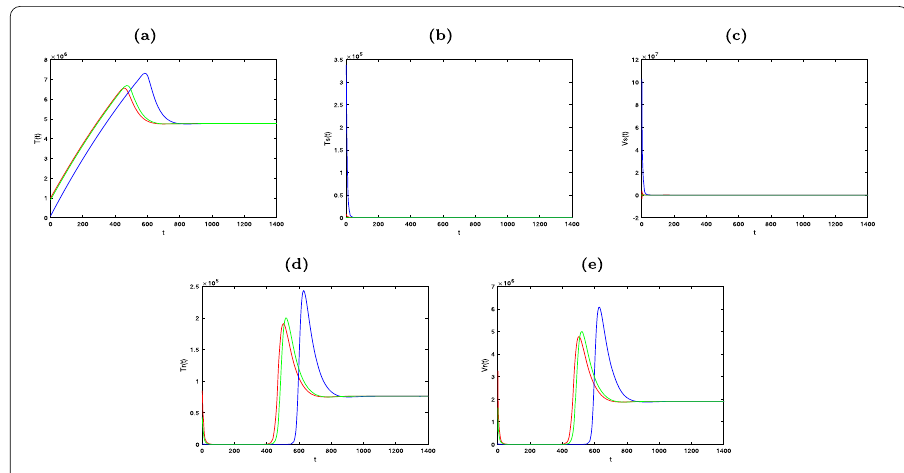
Figure 3 ( a ) Dynamical behaviors of uninfected target cells; ( b ) Dynamical behaviors of infected cells infected by wild-type virus; ( c ) Dynamical behaviors of drug-resistant virus; ( d ) Dynamical behaviors of infected cells infected by wild-type virus; ( e ) Dynamical behaviors of drug-resistant virus